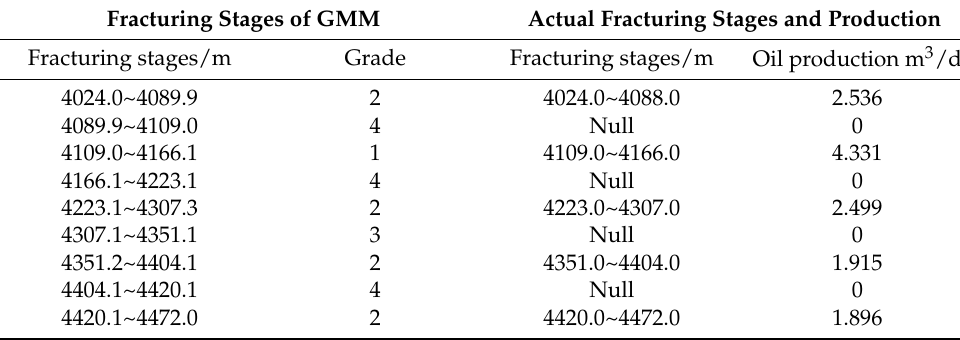
Table 3. Comparison of the test and actual fracturing stages in well B.